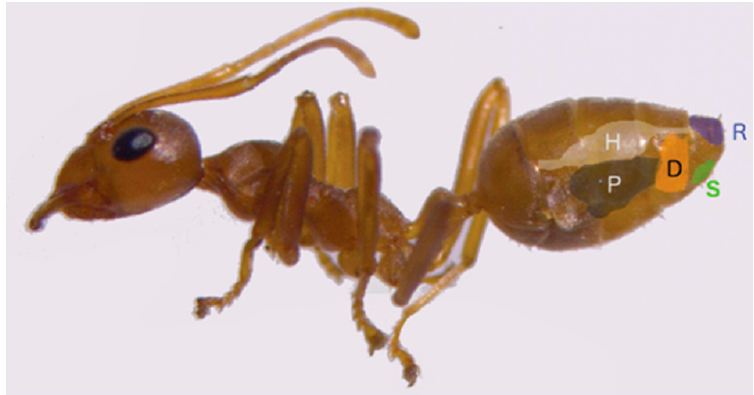
Figure 1. Schematic diagram of worker African weaver ant’s exocrine glands in the abdomen; (P) poison, (D) Dufour’s, (S) sternal, (R) rectal, and (H) hindgut. (P) poison, (D) Dufour’s, (S) sternal, (R) rectal, and (H) hindgut. Each extraction was repeated four times using different glands obtained from different ant populations for each extraction, and samples were stored at − 80 ◦ C until